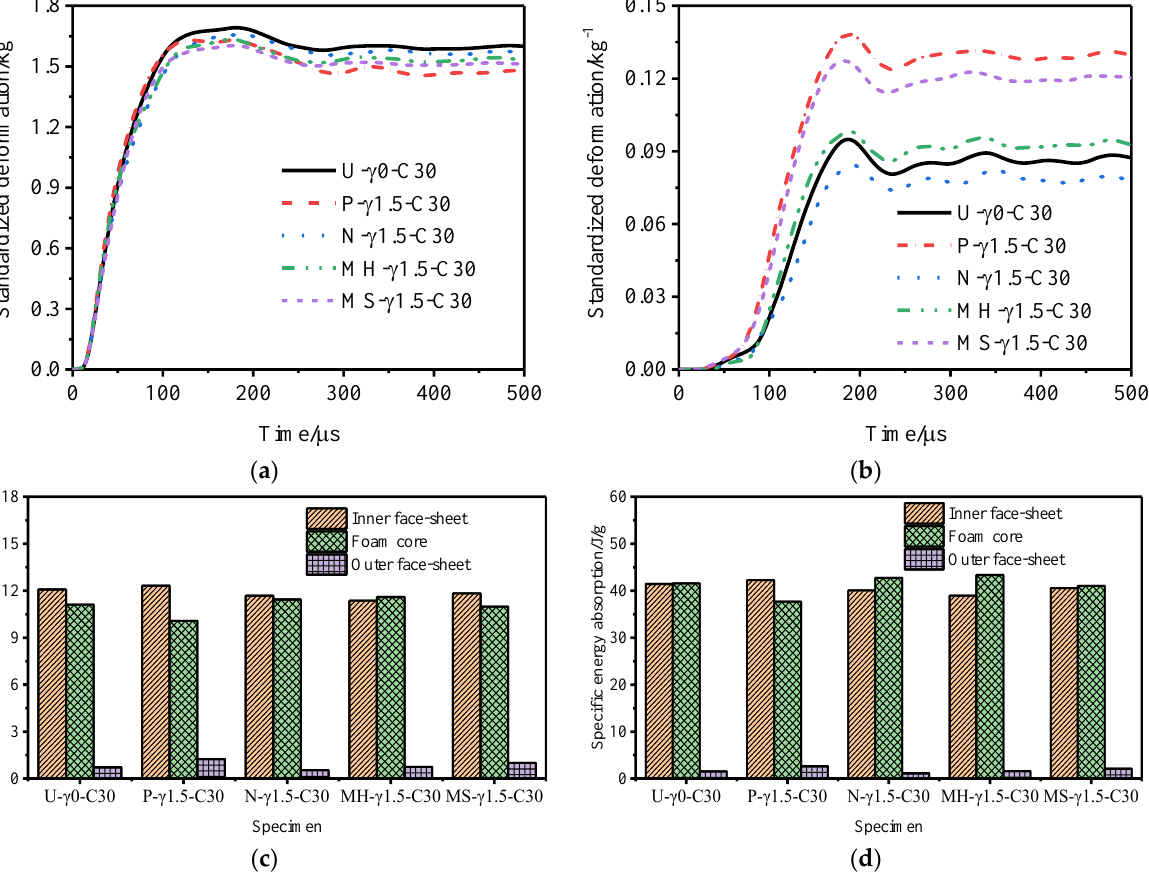
Figure 11. Anti − explosion performance of a foamed aluminum sandwich tube when the core density gradient is 1.5. ( a ) Deformation curve of the inner tube, ( b ) deformation curve of the outer tube, ( c ) total energy absorption of the sandwich tube, and ( d ) specific energy absorption of the sandwich tube.